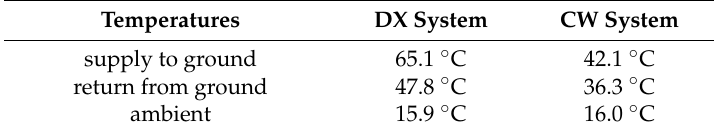
Table 4. The mean ground loop temperatures during their stable continuous operations.